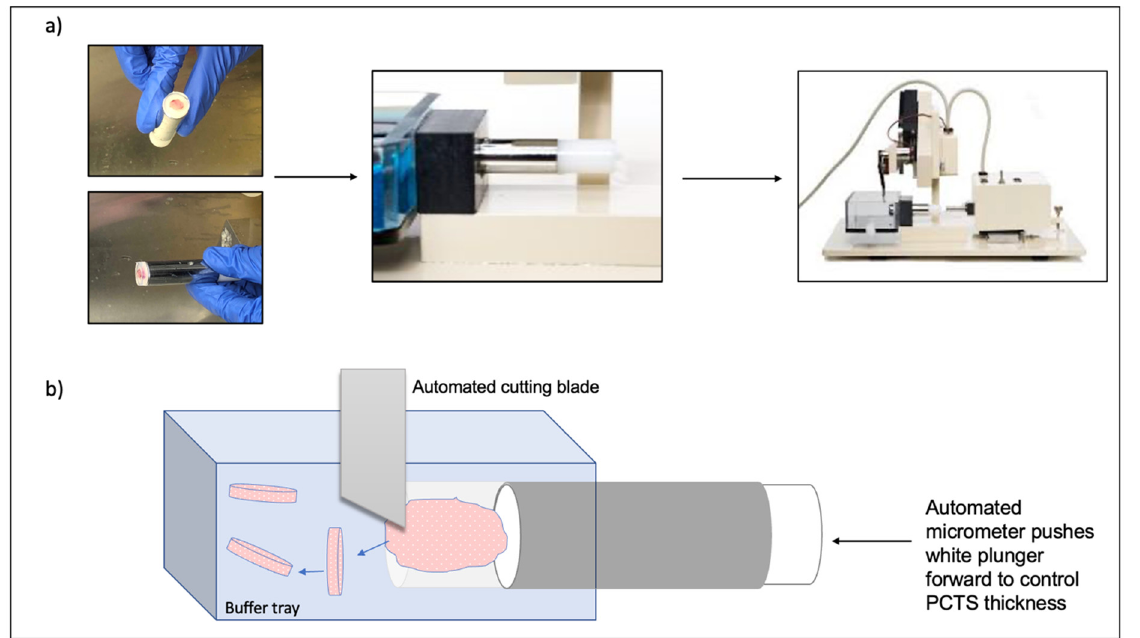
Figure 2. PCTS generation using the Compresstome. ( a ) Tumor samples are embedded in agarose inside specialized tube, on top of a plunger. The tube is then cooled and, once the agarose is solidified, the tube is secured on the Compresstome with the tissue side of the tube being within a buffer tray. ( b ) An automated cutting blade produces serial PCTS, which are free-floating in the buffer tray. To control PCTS thickness, an automated micrometer pushes the specimen tubes white plunger forward after each blade cut.